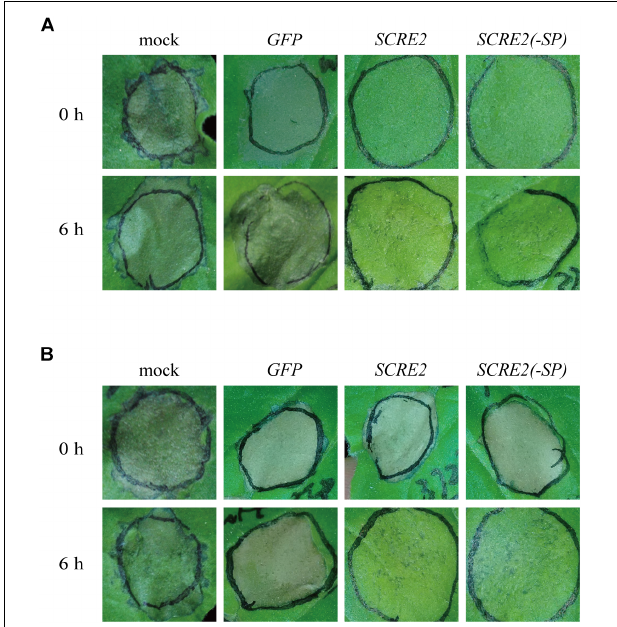
FIGURE 3 | SCRE2 suppresses BAX- and INF1-triggered cell death in N. benthamiana. Expression of BAX (A) and INF1 (B) in N. benthamiana leaves alone triggered necrosis-like immunity symptoms (mock). Transiently expressed SCRE2 and SCRE2(-SP) suppressed cell death triggered by BAX (A) and INF1 (B) in N. benthamiana leaves. The A. tumefaciens strain carrying the SCRE2 gene construct was coinfiltrated with A. tumefaciens cells carrying BAX (A) and INF1 (B) gene constructs either simultaneously (upper panels) or 6 h prior to infiltration (lower panels) into N. benthamiana leaves. SCRE2(-SP) : SCRE2 without the signal peptide. Cell-death symptoms on the infiltrated leaves were photographed at 3 days after the final infiltration. A. tumefacien strains carrying GFP or SCRE2(-SP) were infiltrated into N. benthamiana leaves using the same procedure. SCRE2(-SP) : the SCRE2 gene lacking DNA sequences encoding the signal